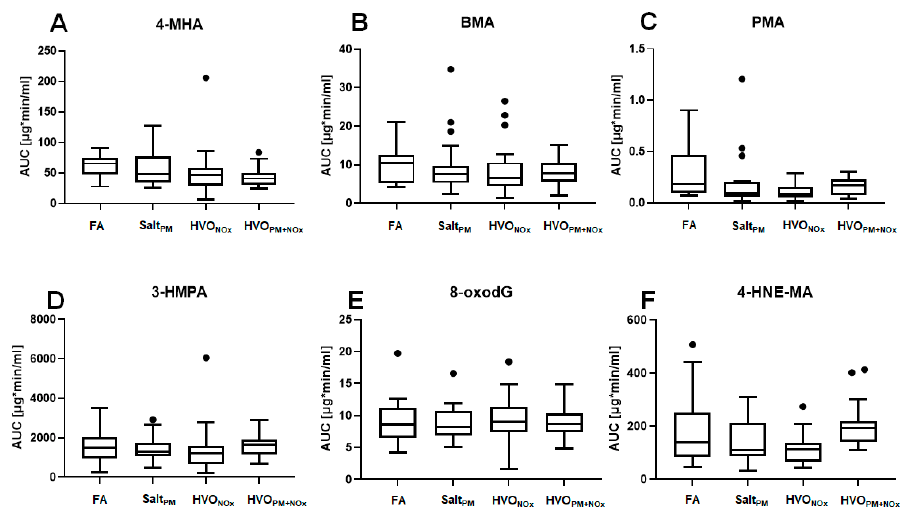
Figure 3. Total excretion of biomarkers, calculated as the area under the excretion curves (AUCs). Box-and-whisker plots display the medians and upper and lower quartiles. Outliers are plotted as individual points. AUCs were calculated for 4-MHA ( A ), BMA ( B ), PMA ( C ), 3-HPMA ( D ), 8-oxodG ( E ), and 4-HNE-MA ( F ), after the following exposure scenarios: filtered air (FA), particle control (Salt PM ), HVO exhaust from a modern non-road vehicle with aftertreatment system (HVO NOx ) and without exhaust aftertreatment (HVO PM+NOx ). Statistical analyses of spot urine samples were performed using Mann–Whitney U test (no significant difference from FA was observed, p < 0.05). All data are presented in Table S5.